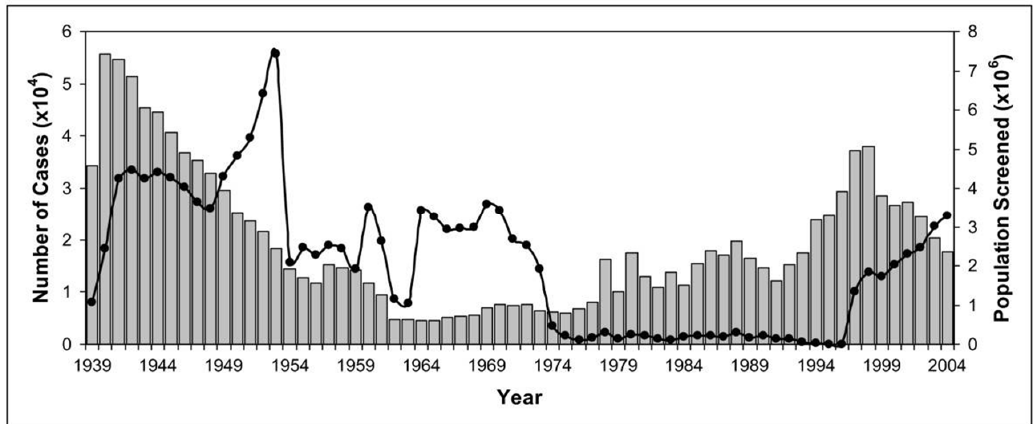
Figure 5. Number of cases of African sleeping sickness reported and population screened [5,10–12]. Graphs show the correlation between population screened (black circles) and number of reported cases (grey columns). Screening and surveillance of endemic disease areas are key to control African sleeping sickness.